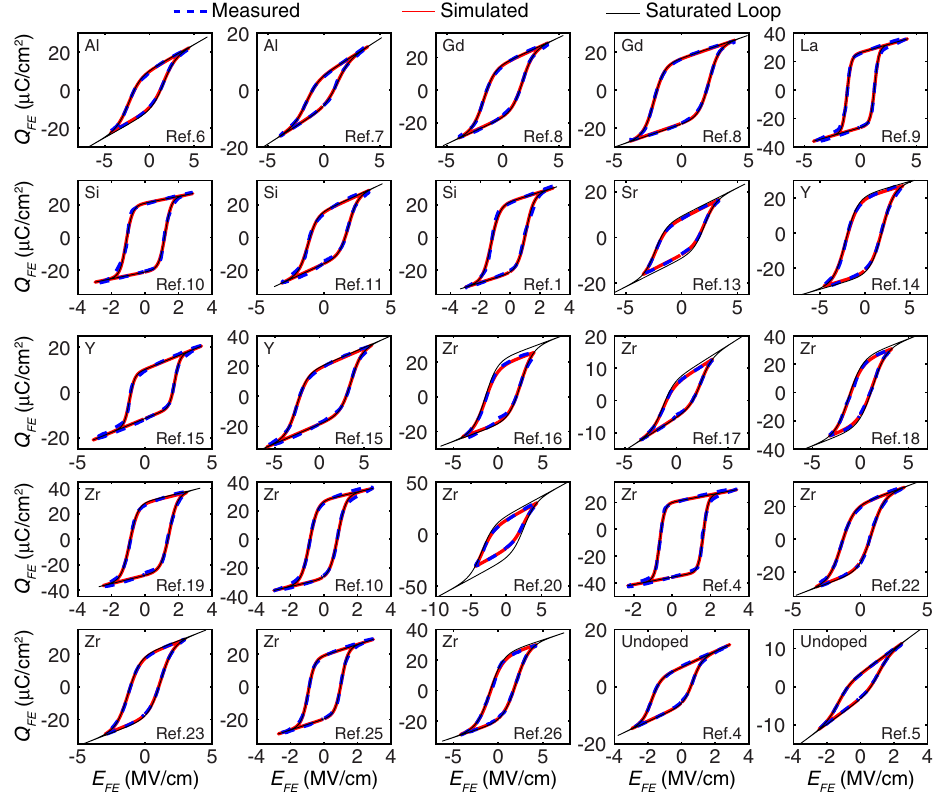
Figure 7. Examples of fitted hysteresis with saturated loops reconstructed based on extracted model parameters for different types of